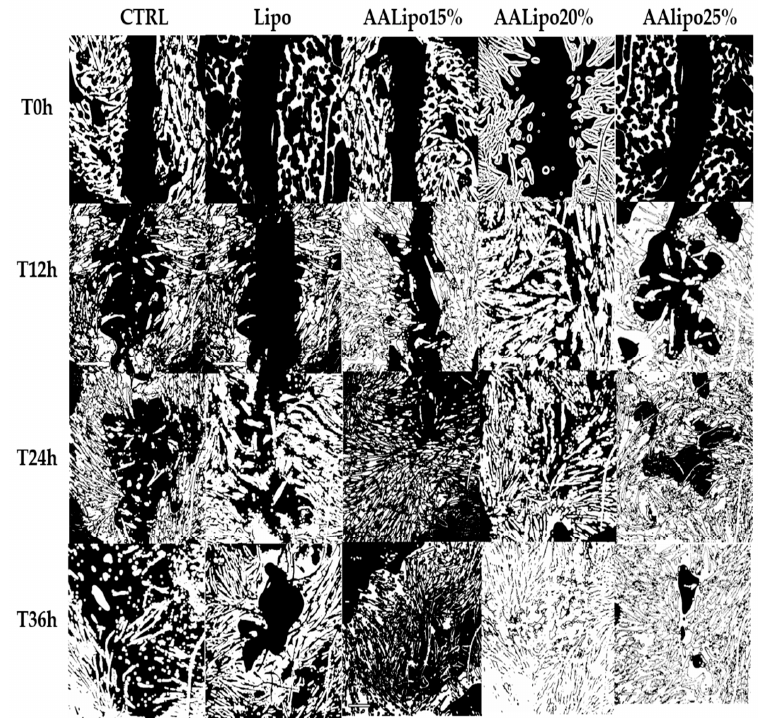
Figure 6. Evolution of wound healing by “scratch” method and fibroblast migration until complete coverage of the gap, influenced by different treatments: CTRL- no treatment; Lipo- blank liposomes; AALipo15%, AALipo20% and AALipo25%- liposomes loaded with AA in concentrations 15%, 20%, and 25% respectively.